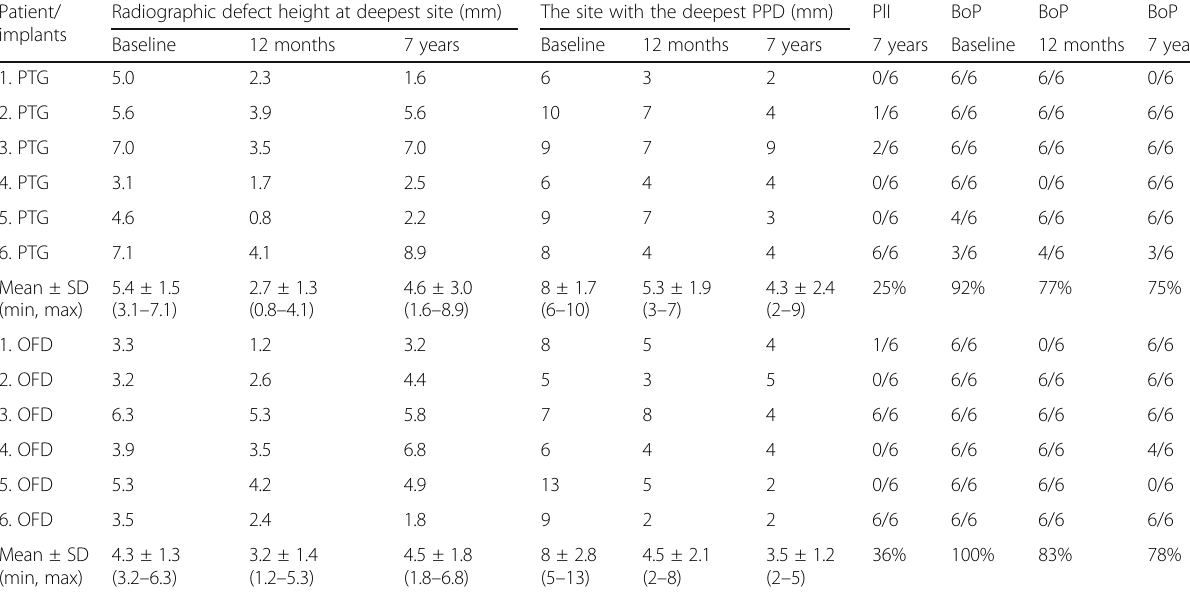
Table 2 Data at baseline, 12 months and 7 years for the PTG and OFD groups Patient/ Radiographic defect height at deepest site implants